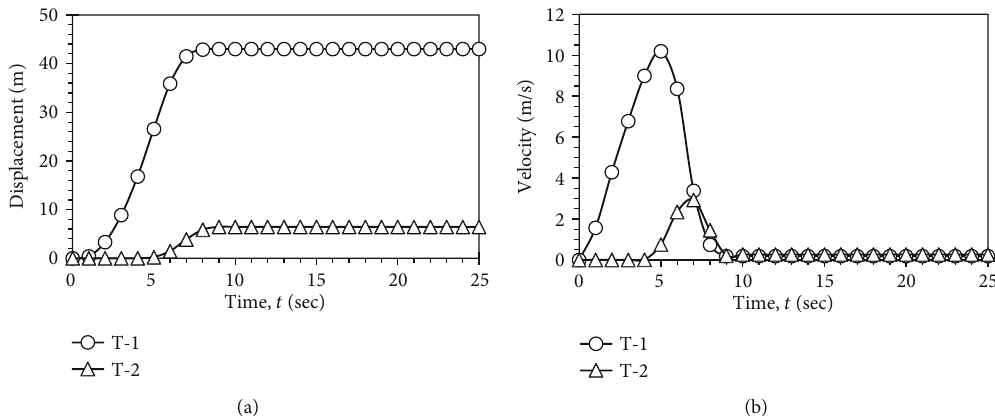
Figure 8: Variation of slope displacement and velocity with time: (a) displacement and (b)